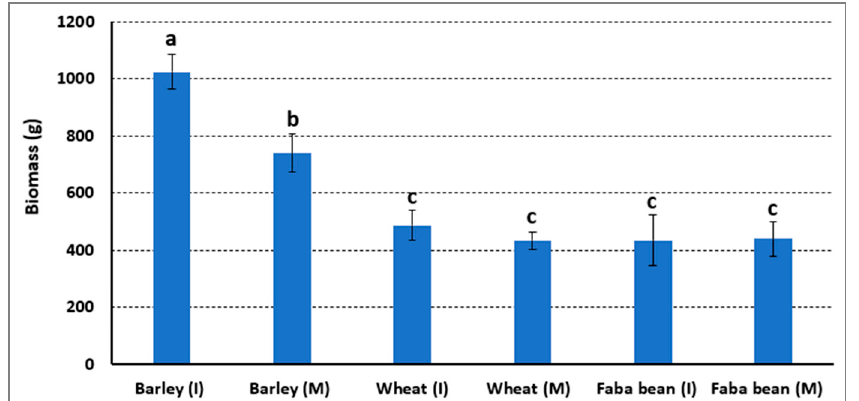
Figure 5. Biomass for the different companion crops (I: intercrop; M: monocrop) in trials Alm1-19(i), Cord1-19(i) and Cord2-19(i). Different letters mean significant differences (Tukey’s test, p < 0.05). Bars for standard errors are shown. Table 5. Height differences between the companion crops and pea in each intercropped plot in trials Cord1-18(i), Alm1-19(i) and Cord2-19(i). Different letters on the same crop mean significant differences (LSD test, p < 0.05).